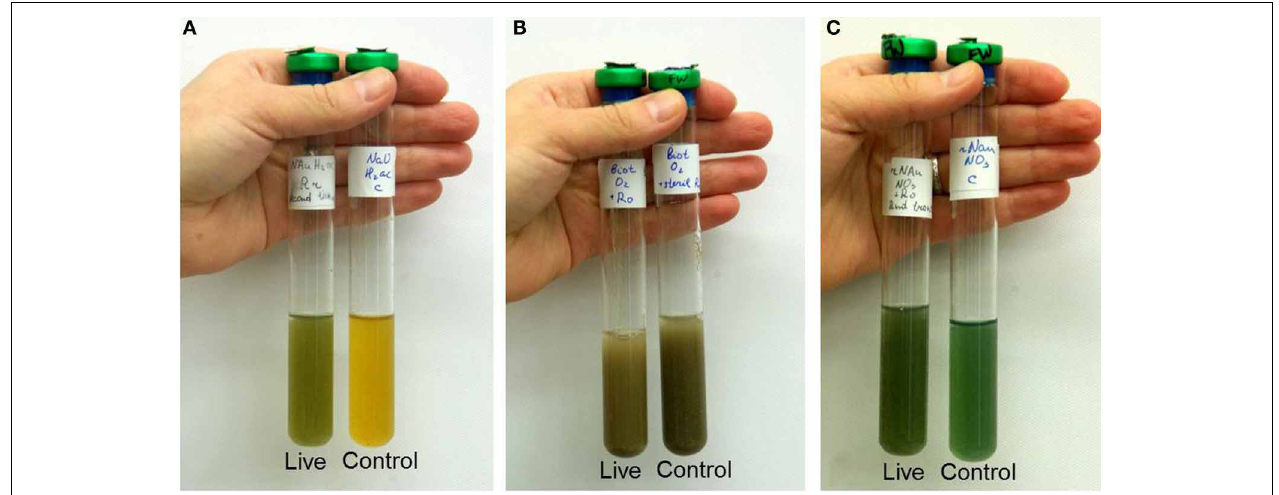
FIGURE A3 | Photos of (A) second transfer of NAu-2 smectite-reducing enrichment from reduced Ringold sediment (8.3mmol Fe(II) L − 1 in live vs. 0.3mmol Fe(II) L − 1 in control; (B) primary biotite-oxidizing enrichment from oxidized Ringold material